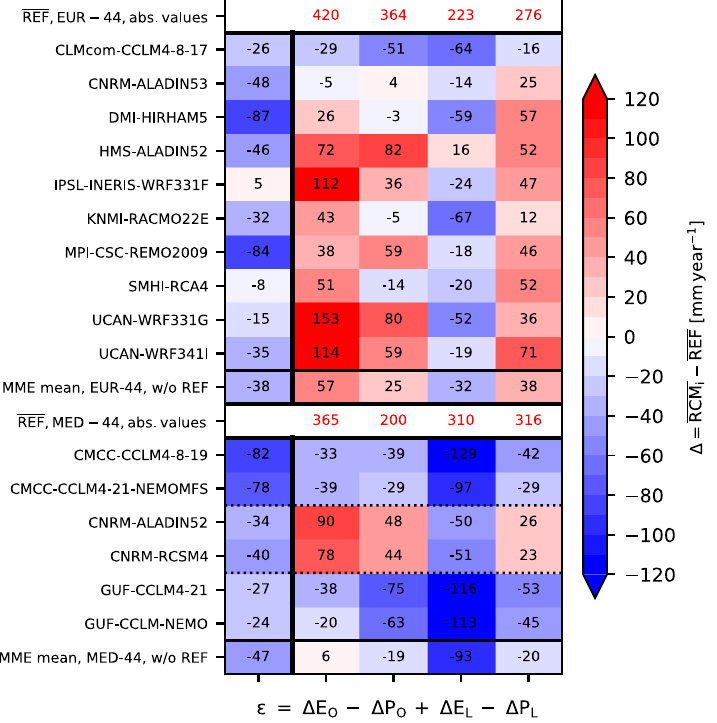
Figure 6. Contribution of atmospheric water budget components to the individual MME member deviation from REF. Upper rows: Pan-European domain; lower rows: Mediterranean domain, the stippled lines separate the different RCM/AORCM model pairs. Columns resemble the terms of Eq. (8), see the x-axis labels. Colours indicate the deviations (RCM i − REF), calculated from 20-year mean annual sums. The upper and lower white rows contain the long-term means of the REF for E O , P O , E L , and P L for the pan-European and Mediterranean model domains, respectively. An area weighing accounts for different land–ocean fractions (using the REFs’ land–ocean